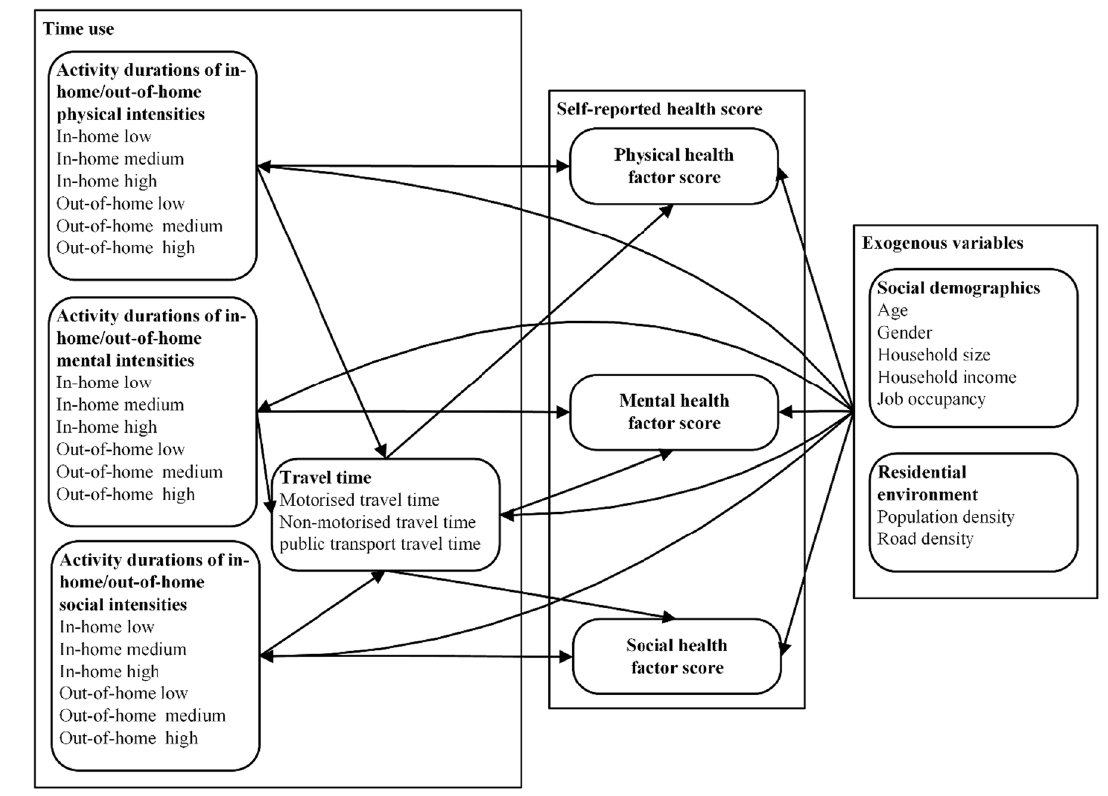
Fig. 4 The path model